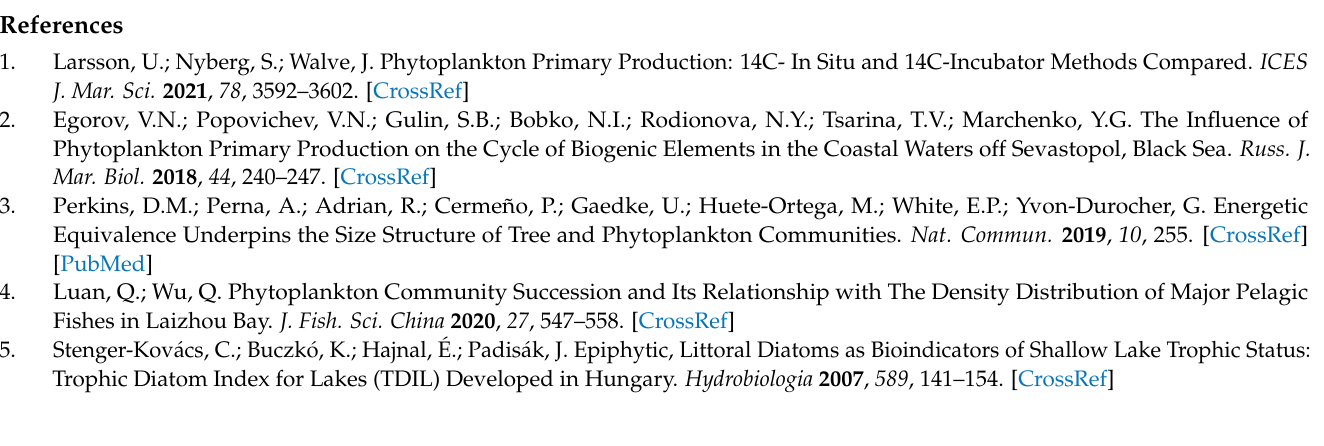
Table S2:·Chlorophyll-a concentration, density and biomass of eukaryotic phytoplankton; Table S3: De- tails of dominant species in Golmud; Table S4: The α -diversity index of eukaryotic phytoplankton community; Table S5: Physicochemical parameters of each sample